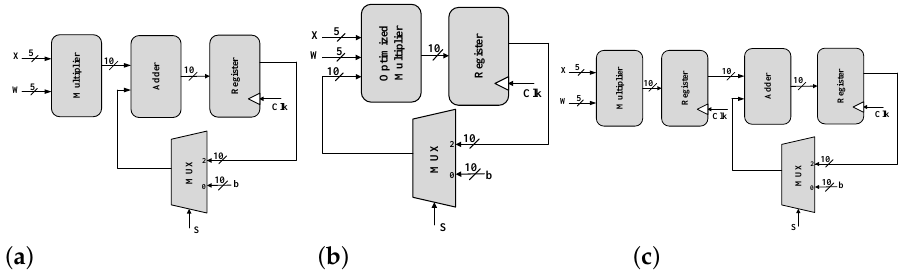
Figure 4. Proposed 5-trit MAC architectures ( a ) serial approach, ( b ) optimized serial and ( c ) pipelined approach.